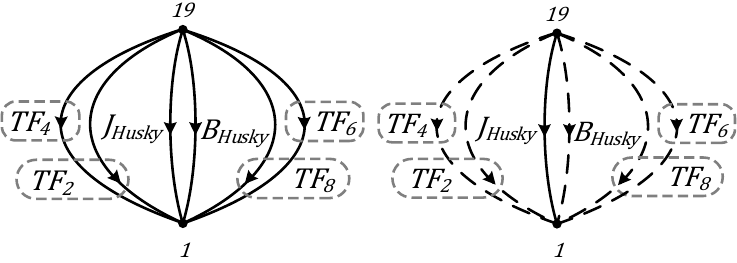
Figure 9. LG model and the normal tree of the Husky robot’s rotational dynamic subsystem. The equations produced by the LGtheory toolbox for the mobile robot rotational dynamics subsystem based on the constitutive equations and the normal tree of the LG model are given next.